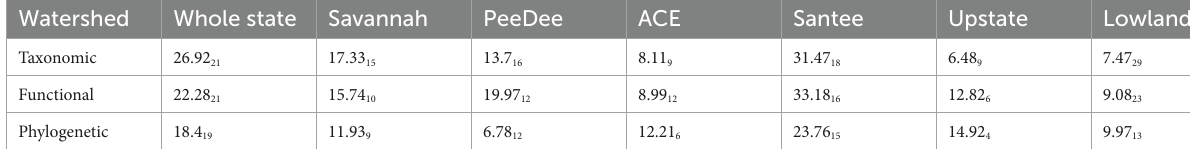
TABLE 5 Statistics (F df ) from variation partitioning analysis of stream fish abundance; all whole model p -values were < 0.0001. Watershed Whole state Savannah PeeDee ACE Santee Upstate Lowlands